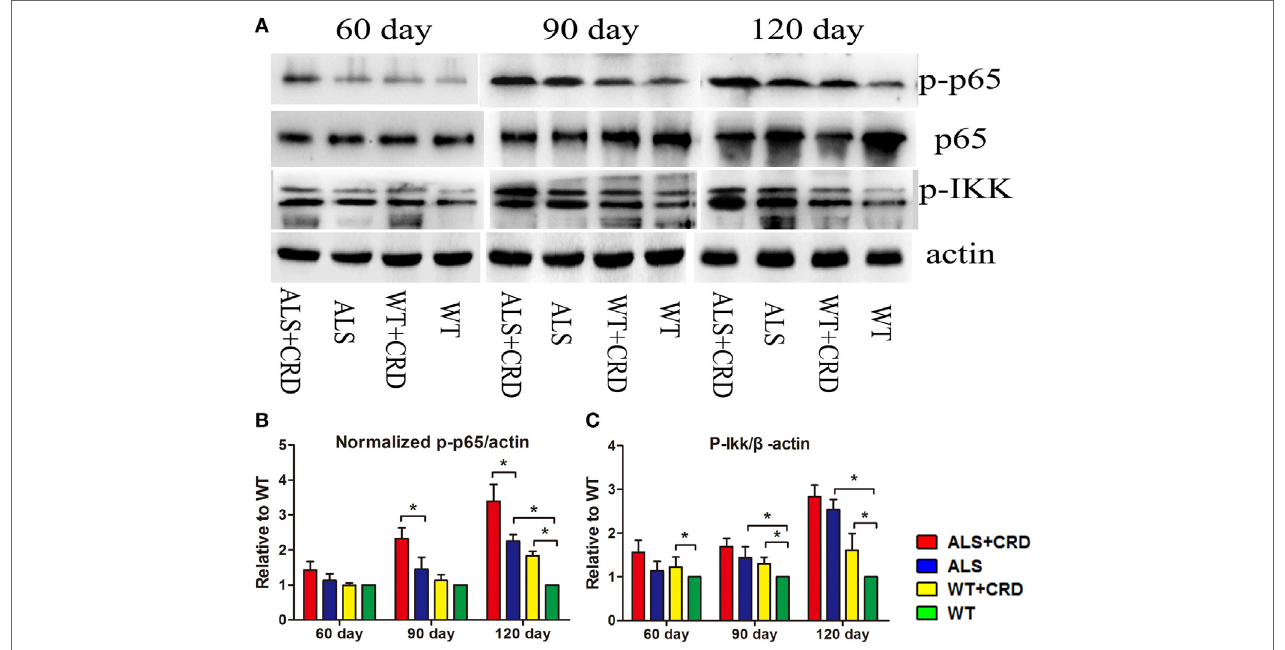
FigUre 3 | Circadian rhythm dysfunction (CRD) aggravated nuclear factor κ B-mediated inflammation in SOD1G93A mice. (a) Expression of p65, p-p65, and p-IKK in the spinal cord. (B,c) Expression of p-IKK and normalized p-p65 was quantified at three stages by western blotting (one-way ANOVA, n = 2–3 animals per group). ** p < 0.01; * p < 0.05. Error bars represent